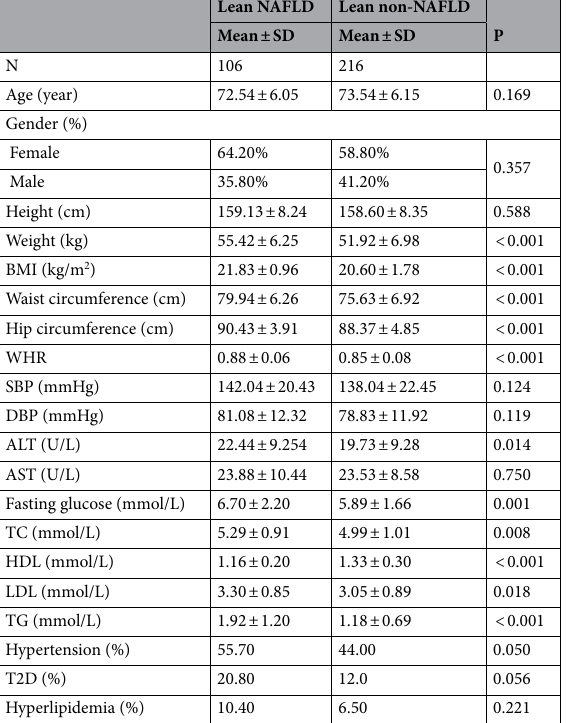
Table 1. Clinical characteristics of lean NAFLD and lean non-NAFLD individuals. Variables are presented as mean ± SD. P values are based on independent sample t- test. ALT alanine aminotransferase, AST aspartate TG triglyceride, T2D type 2 diabetes, WHR waist to hip ratio.